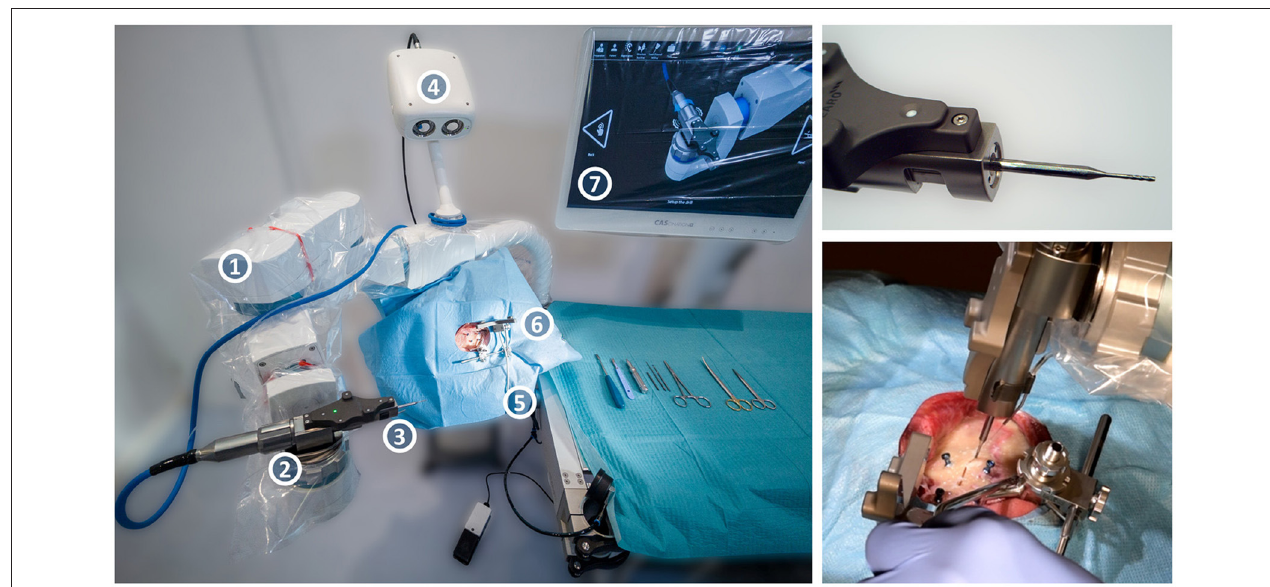
FIGURE 4 | The HEARO robotic surgical system, consisting of the five-axis HEARO Robot (1) with a tracked HEARO Drill end-effector on the quick-release wrist mount (2), the cylindrical milling cutter (3), a high-precision tracking camera (4), and a carbon-fiber headrest with air-pressure cushions (5) under a draped specimen with a patient marker attached (6). The navigation software displayed on the draped screen guides the surgeon through the procedure (7). On the top right, a close-up of the end-effector with the milling cutter, and on the bottom right the robotic system in the process of milling a channel during the ex-vivo study.